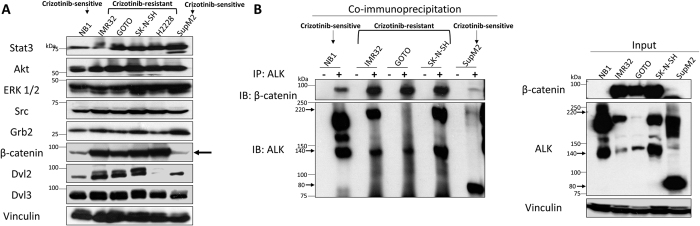
β-catenin interacts with ALK and shows of higher expression levels in Crizotinib-resistant cell lines.(A) Screening of a panel of known ALK-effector proteins identified β-catenin as a protein that was highly expressed in Crizotinib-resistant cell lines (i.e. IMR32, GOTO, SK-N-SH, and H2228). Please note that the Western blot from Supplementary Figure 1 was analysed here against indicated antibodies. (B) Left panel, ALK pull-down experiment showed substantial ALK-β-catenin binding only in Crizotinib-resistant cell lines (i.e. IMR32, GOTO and SK-N-SH). Right panel, the input for the co-immunoprecipitation.